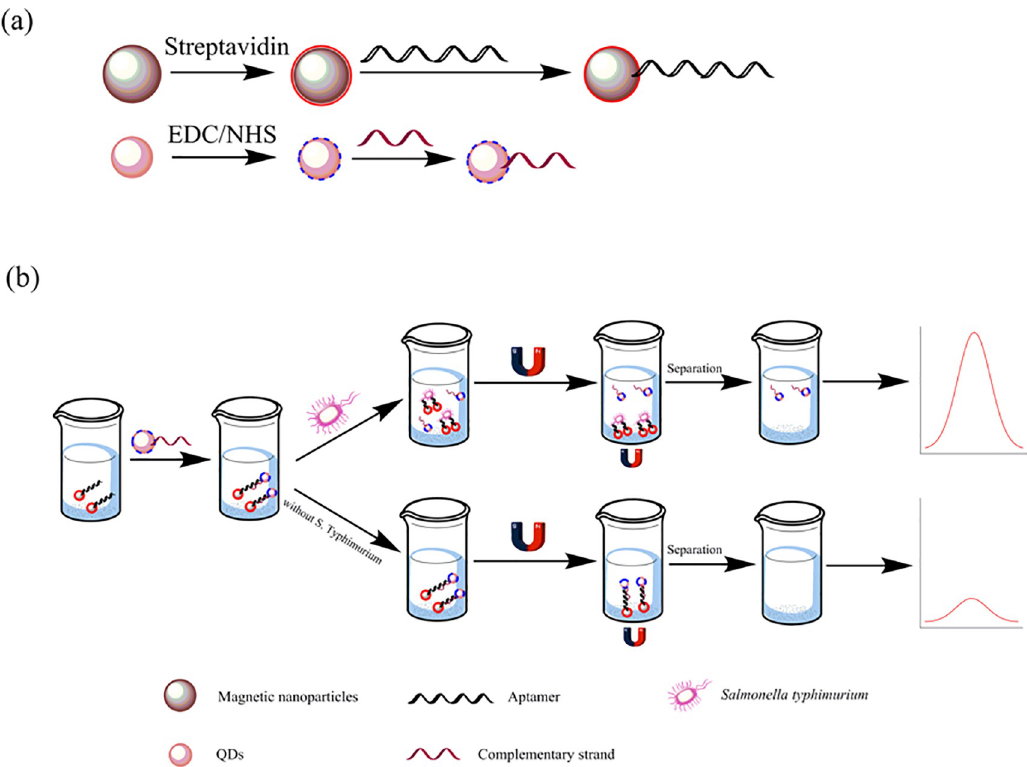
Fig 2. Schematic diagram of ( a ) the synthesis of streptavidin magnetic nanoparticles and carboxyl CdTe QDs, ( b ) illustration of the detection of S . Typhimurium .